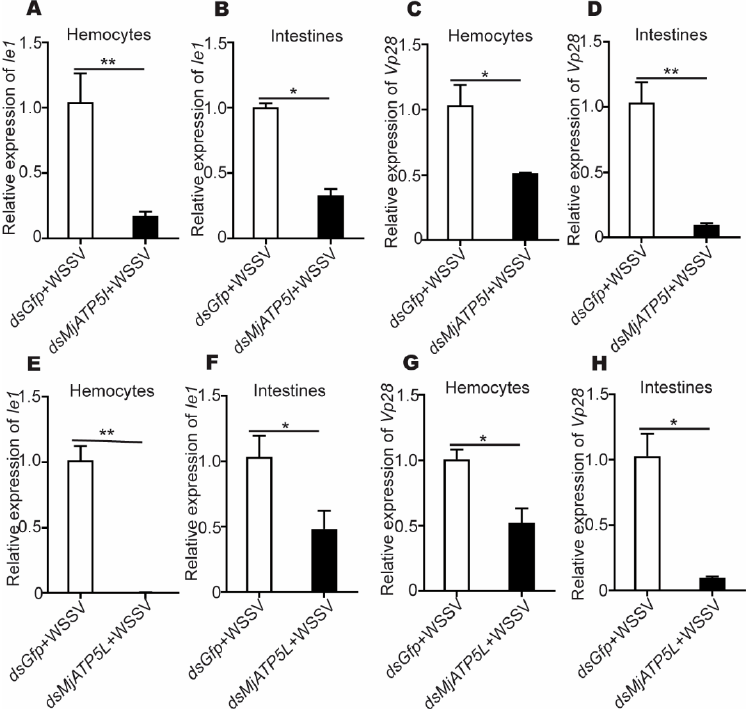
Figure 6. The relative expression of Ie1 and Vp28 after RNAi. ( A – D ) The relative expression of Ie1 ( A , B ) and Vp28 ( C , D ) in hemocytes and intestines after MjATP5I knocking down. ( E – H ) The relative expression of Ie1 ( E , F ) and Vp28 ( G , H ) in hemocytes and intestines after MjATP5L knocking down. The results are expressed as the mean ± SD and significant differences were analyzed between the dsMjATP5I -injected or dsMjATP5L -injected group and the dsGfp -injected group using Student’s t - test. *, p < 0.05, **, p < 0.01. 3.4. MjATP5I and MjATP5L Influenced the Shrimp Survival Rate and the Production of ATP